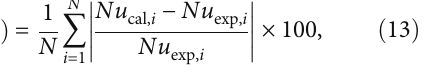
Þ Þ and peak value ( ð dT ) of the change rate of the gas outlet temperature with the g,out g,out mean peak under di ff erent gas velocities u p g